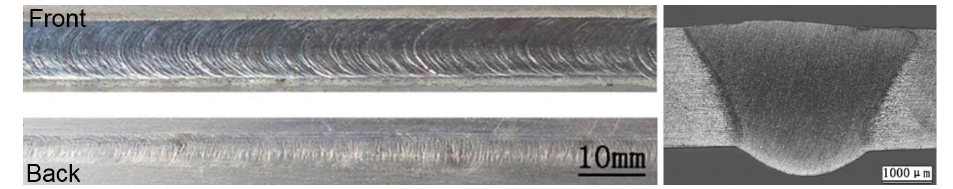
Figure 4. Appearance and the macrostructure of hybrid welding Al alloys joint. Table 4. Best parameters for 3 mm thick Al alloys hybrid welding process.